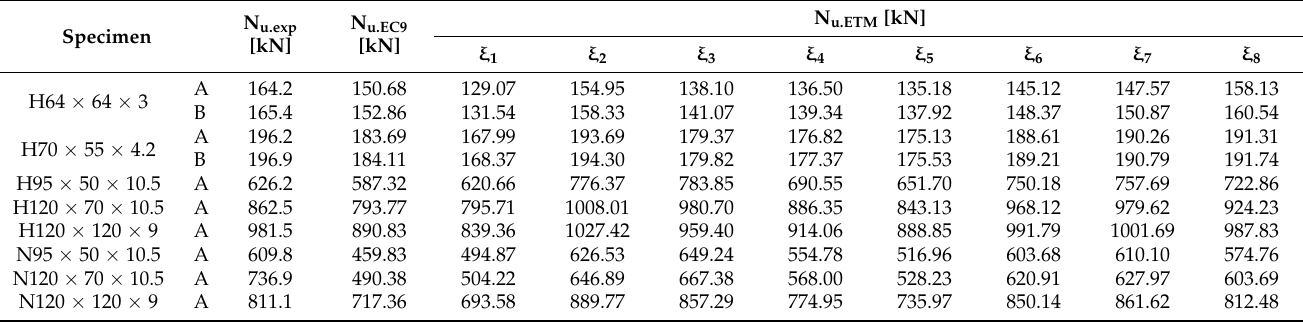
Table A3. Comparison between the theoretical and experimental results in the case of uniform compression. Specimen